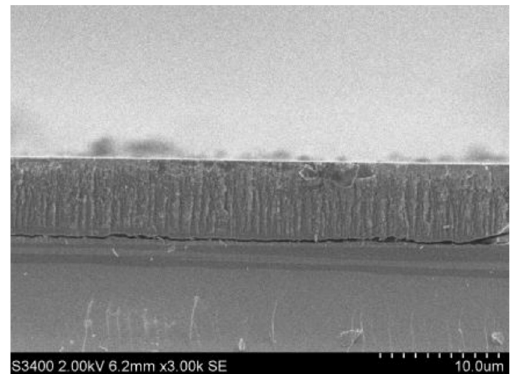
Figure 3. Preparation of porous silicon microstructure.